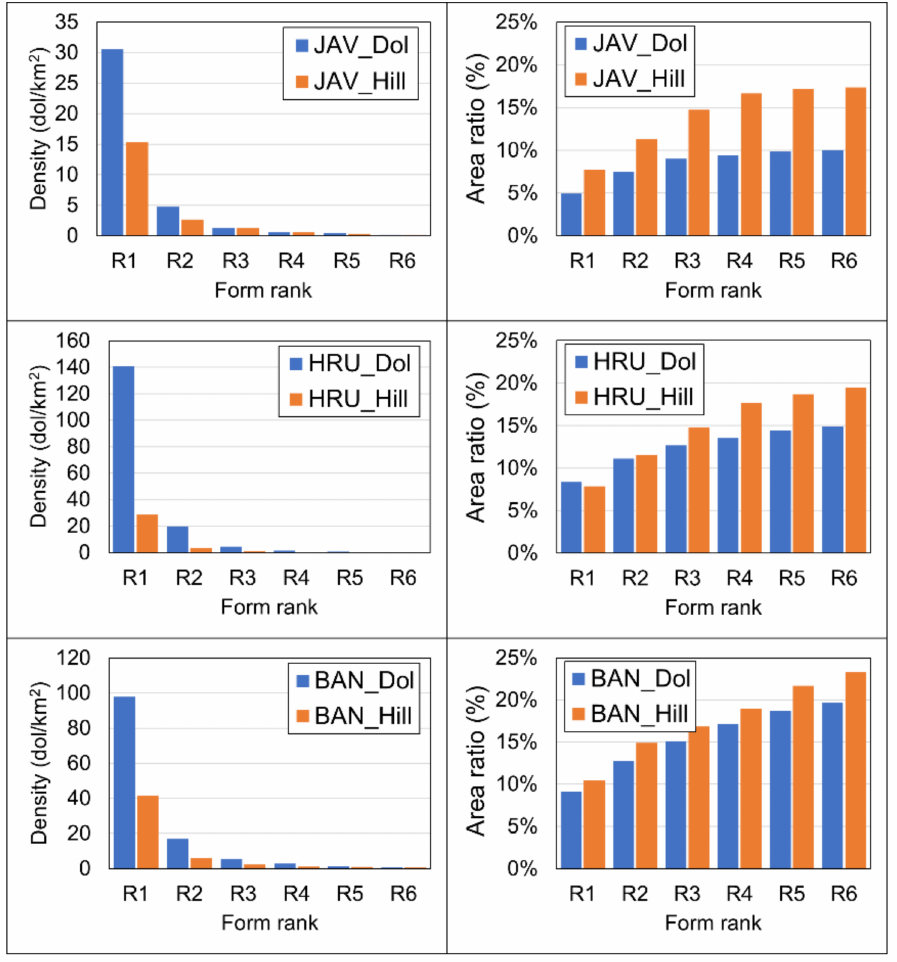
Figure 6. Left : doline and hill density values by form rank. Right : doline and hill area ratios by form